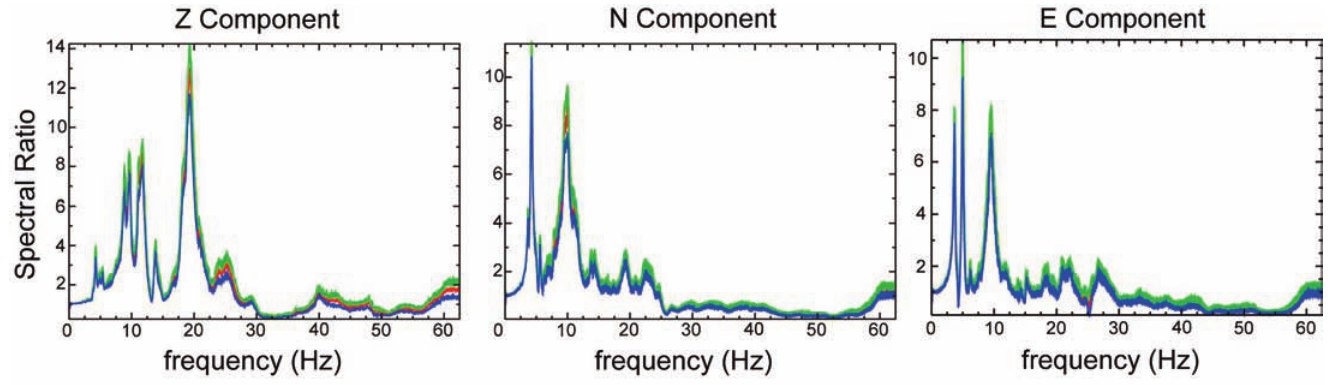
Figure 10. Spectral ratios for each component, between the internal MRV2 and external MRV0 spectra. These relative spectra shows several peaks, with amplitudes between 8 and